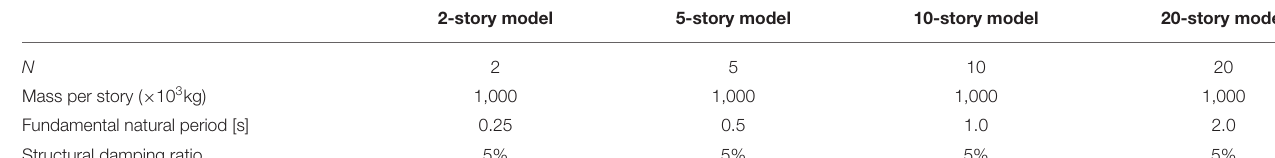
TABLE 2 | Parameters in building structures.